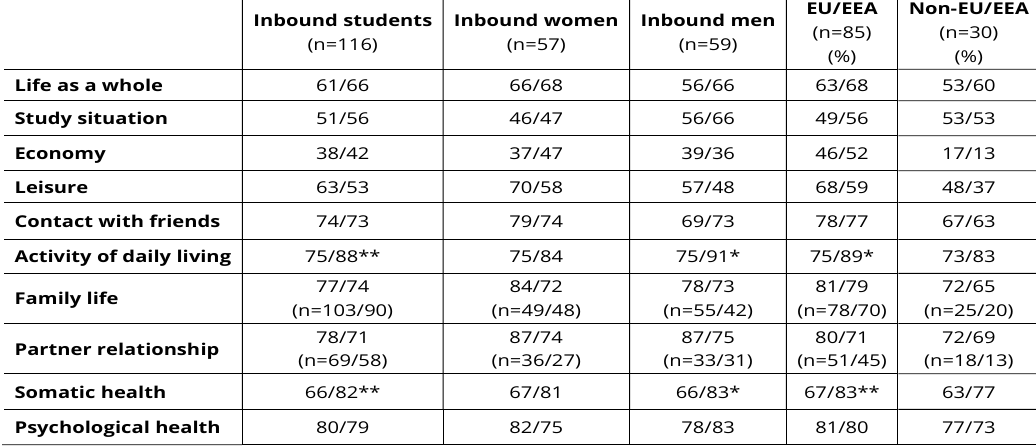
Table 3. Differences in self-reported levels of life satisfaction (in percentages of very satisfied and satisfied, dichotomized as ‘satisfied’ in accordance with the developer of LiSat-11) for inbound students, inbound women, inbound men, European students, and non-European students before vs. after studying abroad (** p <0.01, * p